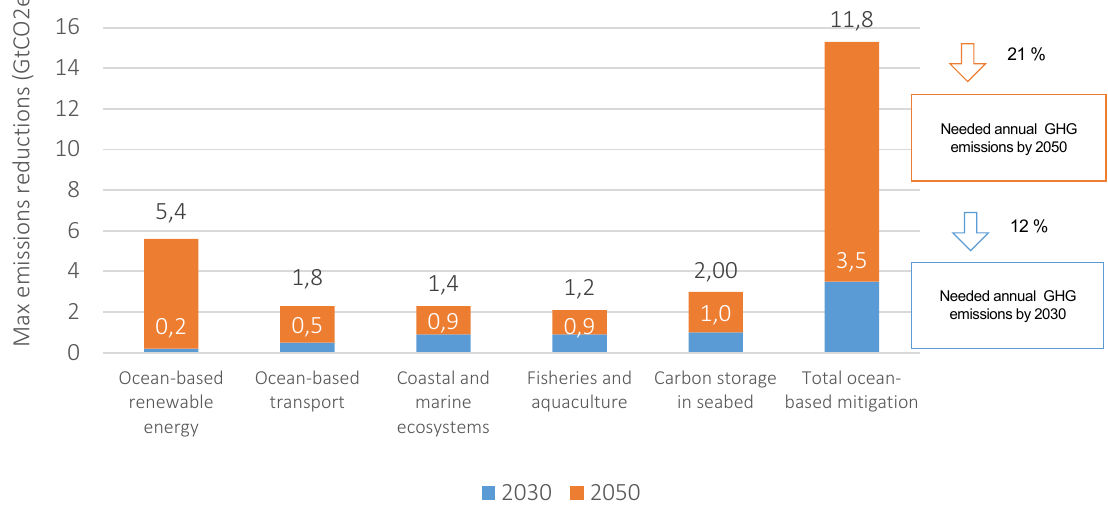
Figure 2. Mitigation of climate change in 2030 and